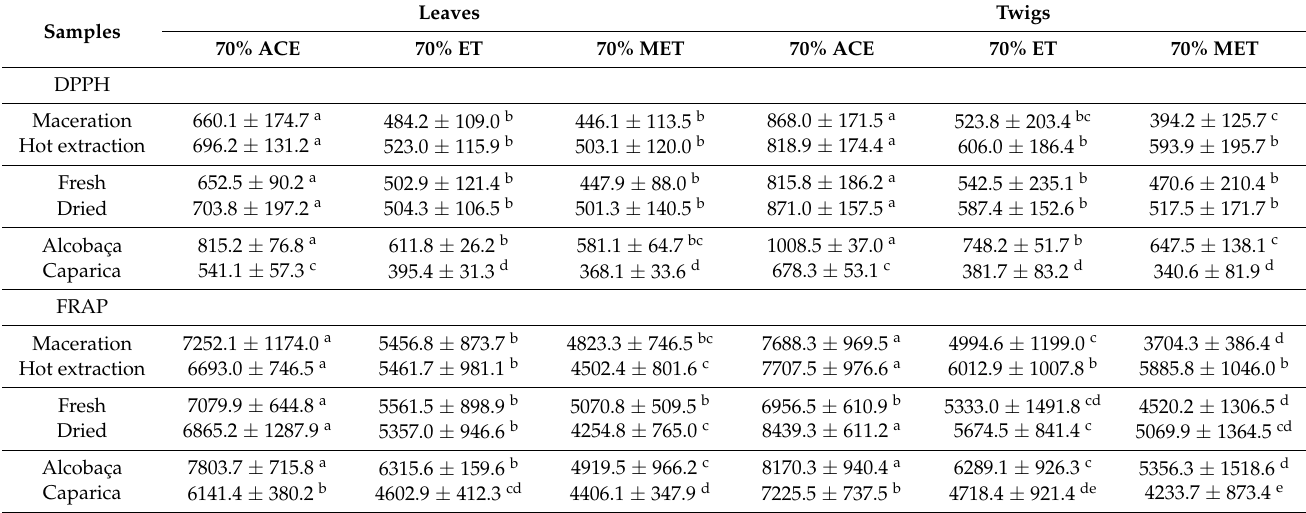
Different letters indicate significant differences of means within samples for each set of parameters (one-way ANOVA, Tukey test at p <